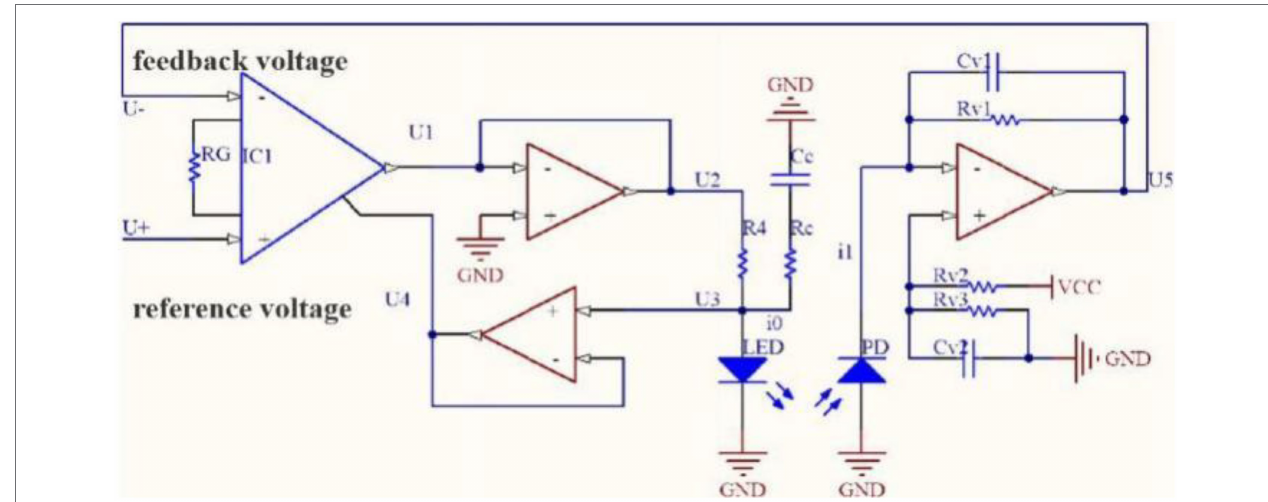
FIGURE 11 | Optical power feedback drive circuit.